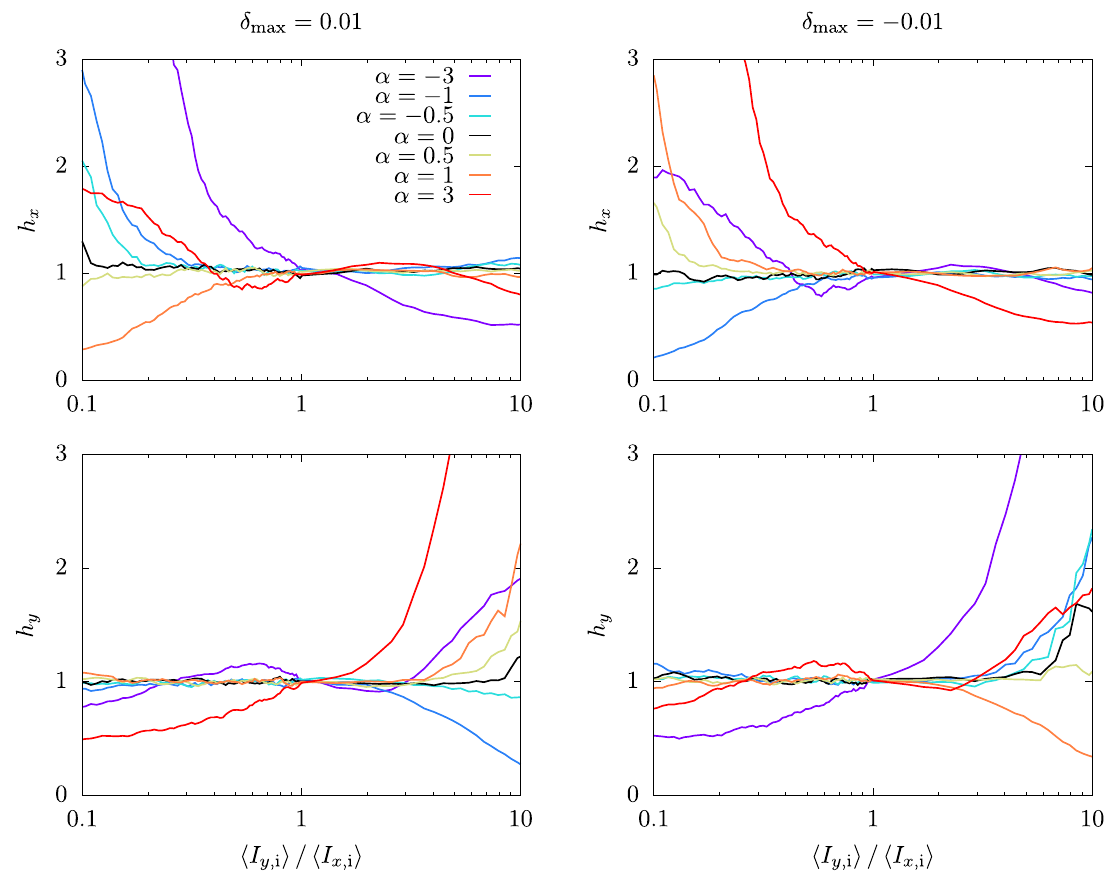
= h I x; i i , i i 0 . 01 , K 10 , 3 ¼ max ¼